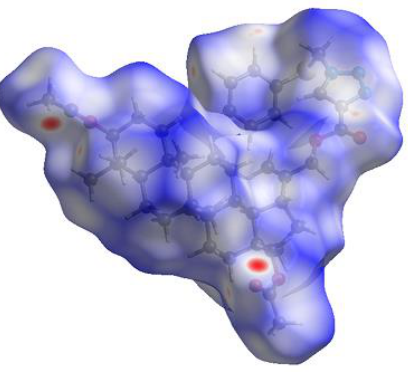
Figure 6. The Hirshfeld surface for 4 . The d norm is viewed from the c-axis. Comparing Figures 4 and 6 shows that the red regions are localized near the acyl groups at positions C-3 and C-28 containing carbonyl oxygen atoms, which create the hy- drogen bond. The triazole ring involving in long distance interaction, is visualized by blue color. Figure 7a–d presents the quantitative analysis of intermolecular contacts using 2D fingerprint plots for compound 4 . The 2D fingerprint plots show that the intermolecular interactions are dominated by the O–H interaction. The sharp spike in Figure 7c indicates the presence of the O…H hydrogen bonds. The N…H and C…H interactions comprise 7.5% and 8.0% of the total Hirshfeld surface, respectively. The full 2D fingerprint plot for 4 is presented in Supplementary Materials (Figure S7). All interactions observed for 4 are summarized in Table 3 with their percentage contributions to the surface. ( a ) C…H